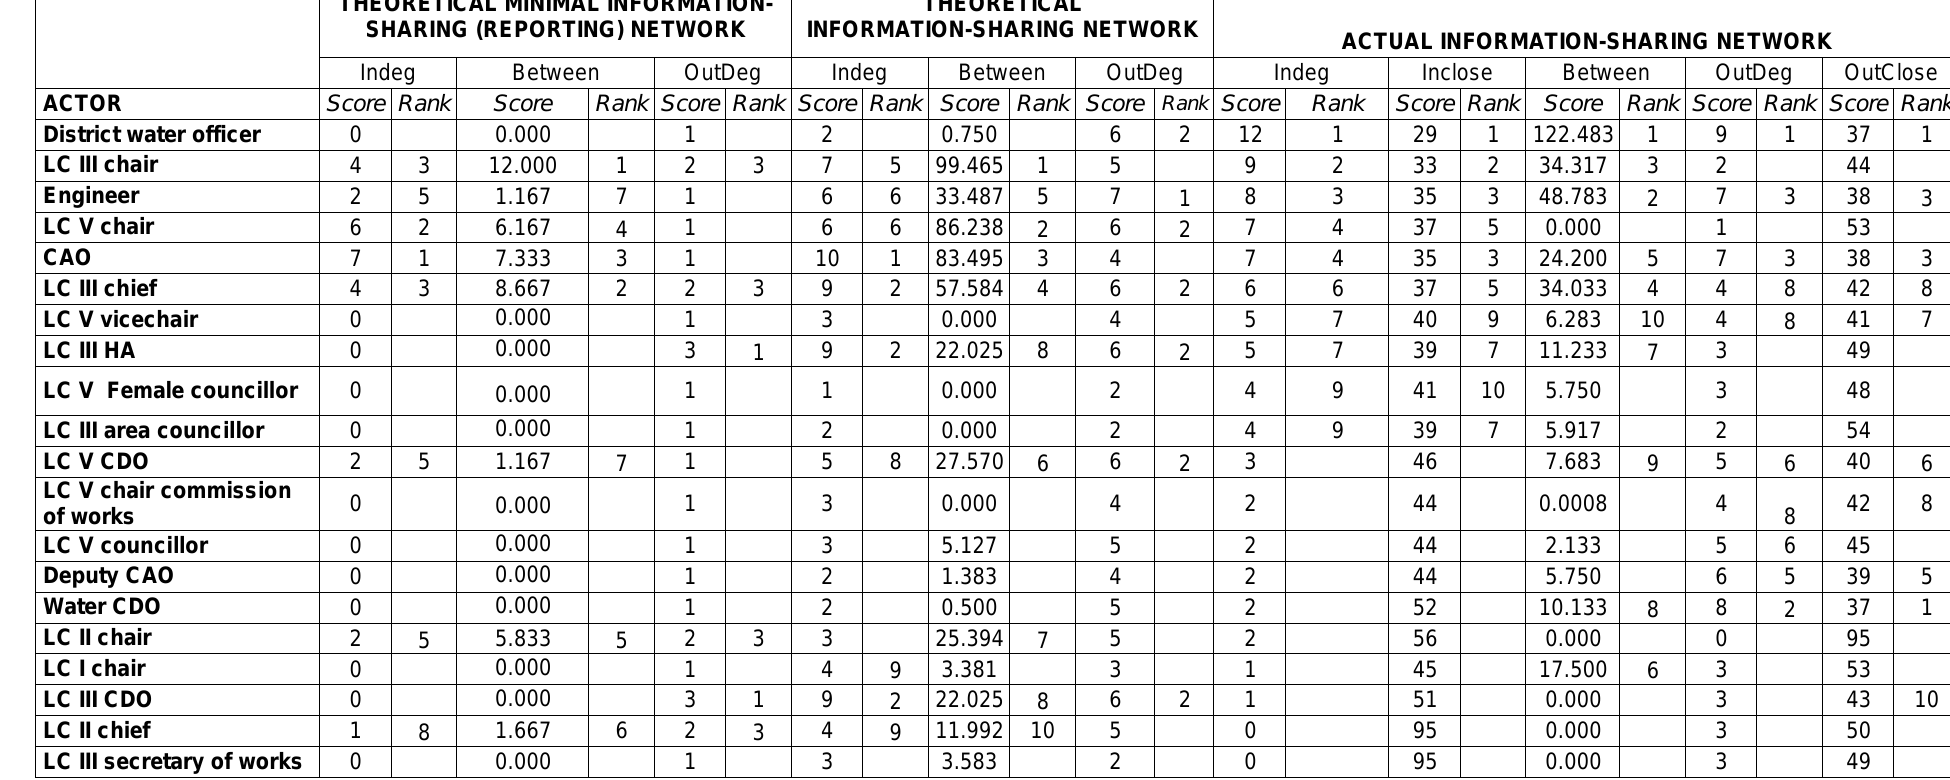
Table 2: Government actor scores on centrality measures by social network model THEORETICAL MINIMAL